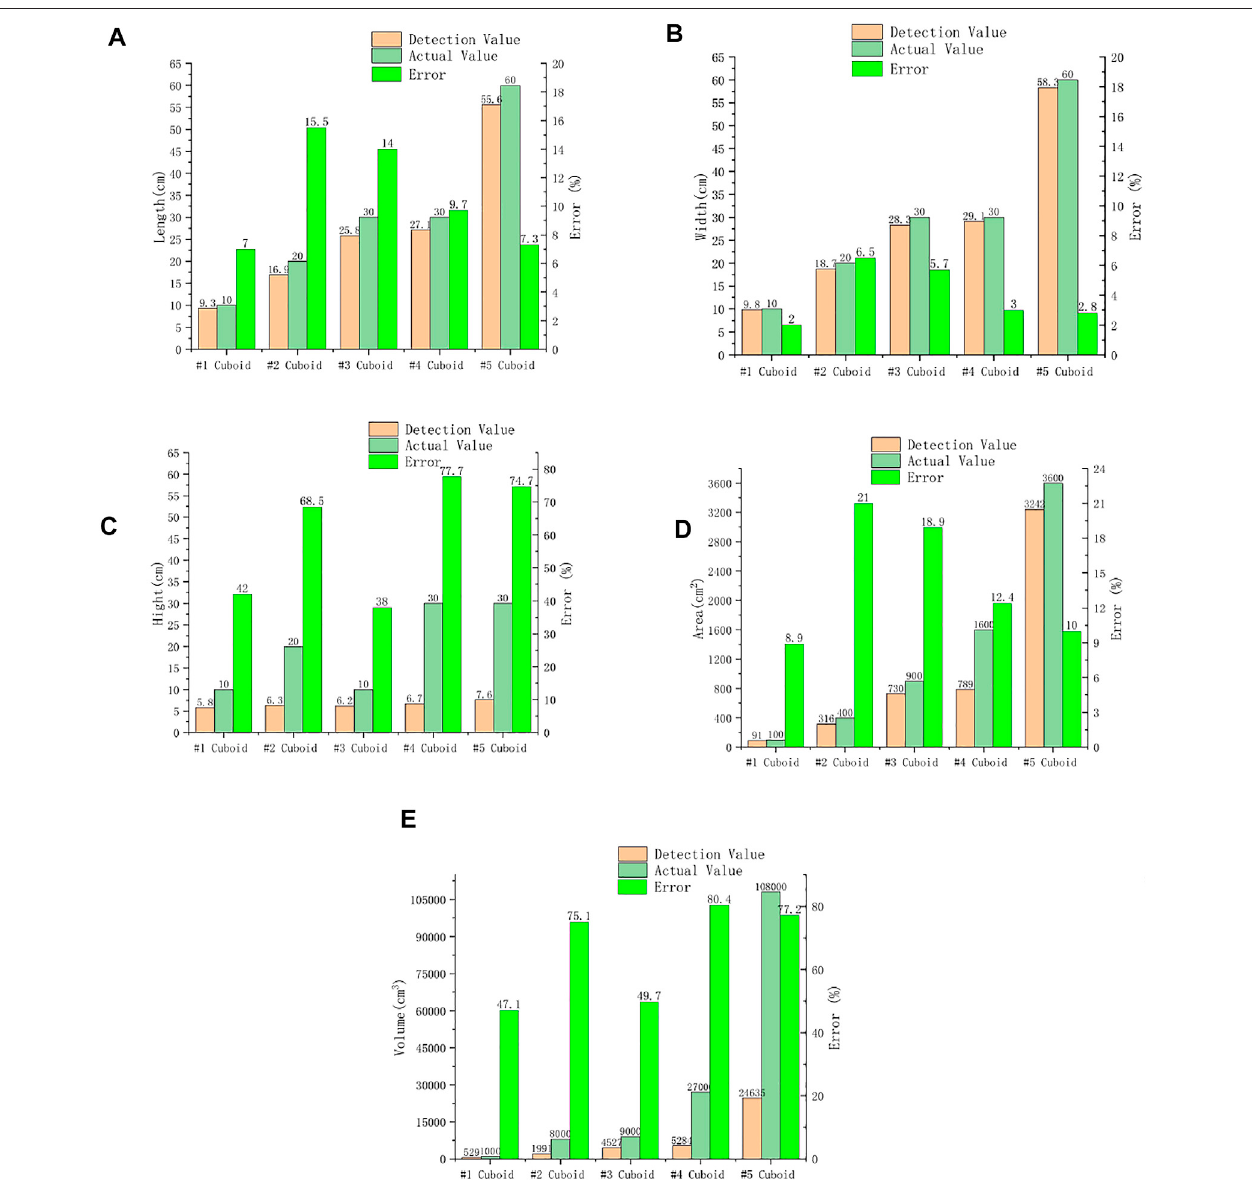
FIGURE11| Comparison andanalysisofpolystyreneblockvolume index testresultsand actual values. (A) Comparison ofthelengthofthepolystyreneblock with the actual value. (B) Comparison of the detection result of polystyrene block width with the actual value. (C) Comparison of the detection result of the height of the polystyrene blockwiththeactual value. (D) Comparison ofthedetection result ofthepolystyreneblock areawith theactual value. (E) Comparison ofthedetection result of the polystyrene block volume with the actual value.